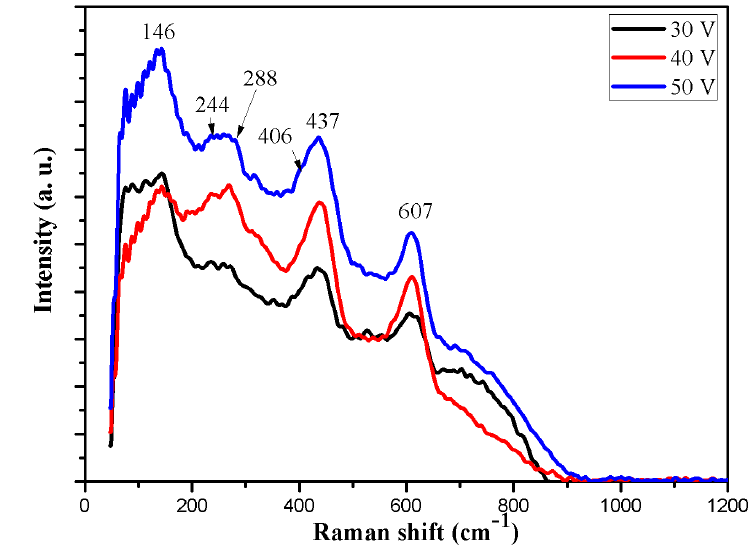
Figure 5. Raman shift of Ti-Ni-O fabricated at different pulse voltages, ( a ) 30 V; ( b ) 40 V; ( c ) 50 V.